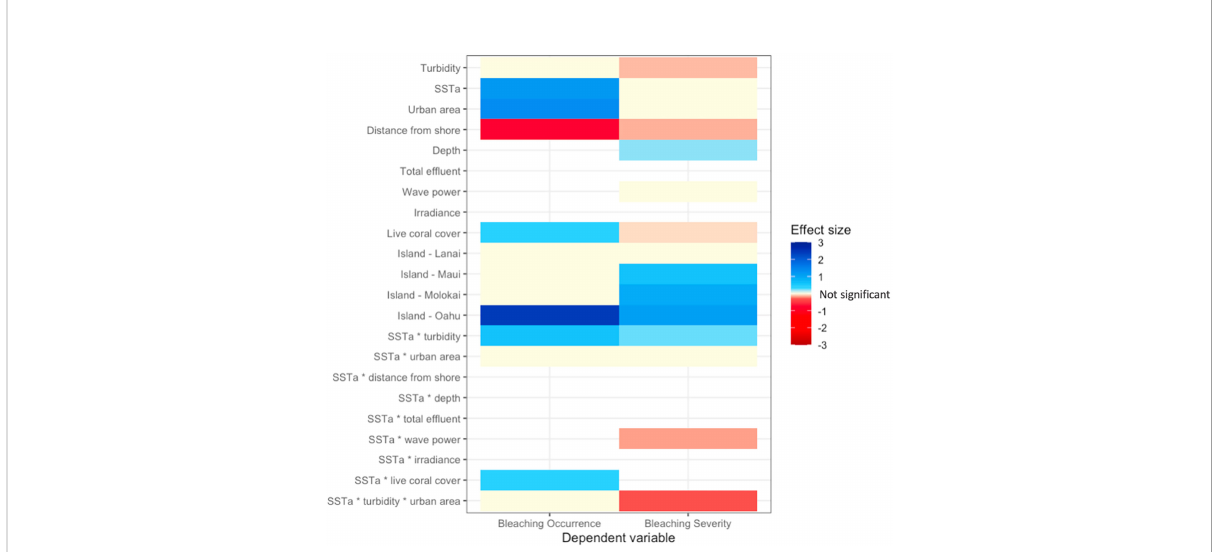
FIGURE 6 Heatmap of effect sizes for independent variables in fi nal models for bleaching occurrence (left column) and severity (right